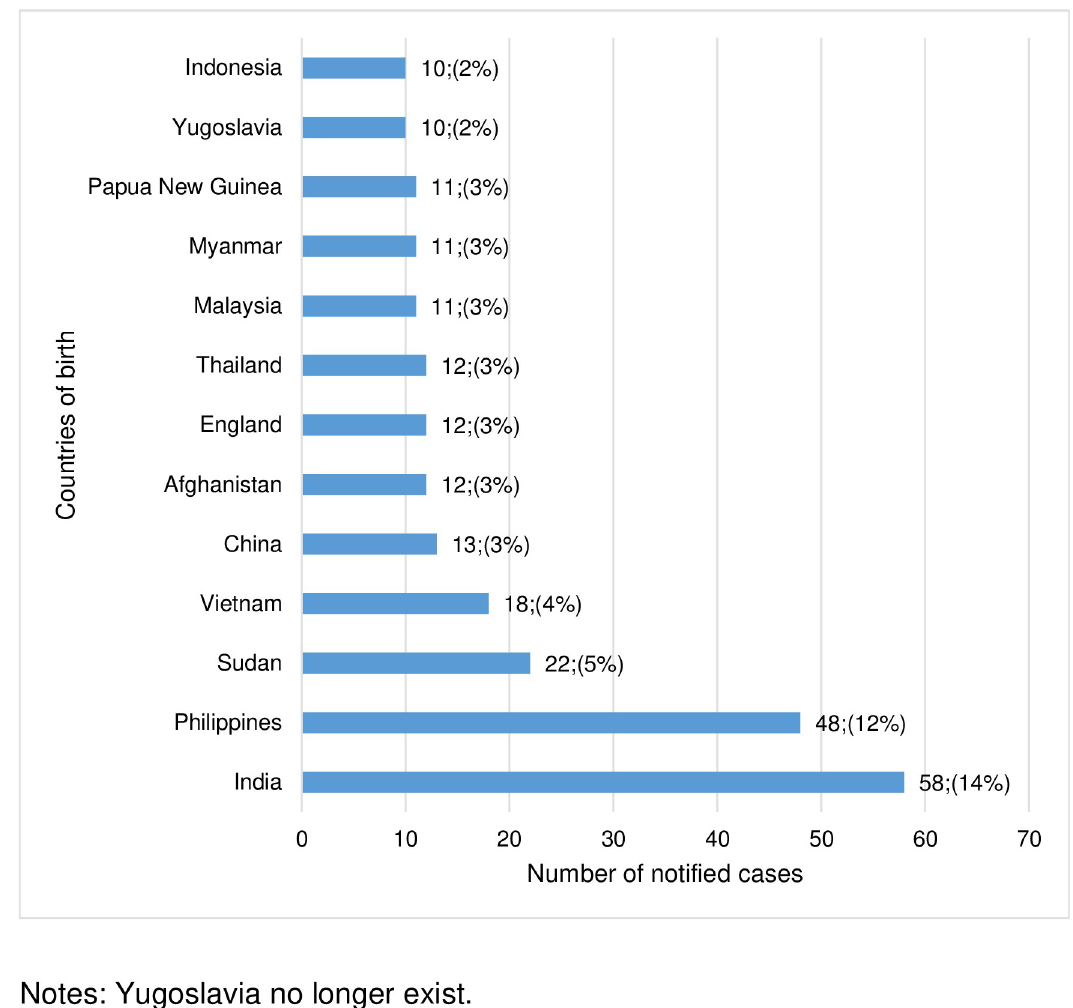
Fig 4. Notified cases of tuberculosis in regional Victoria for overseas-born people from 1999 to 2019, by country of birth.